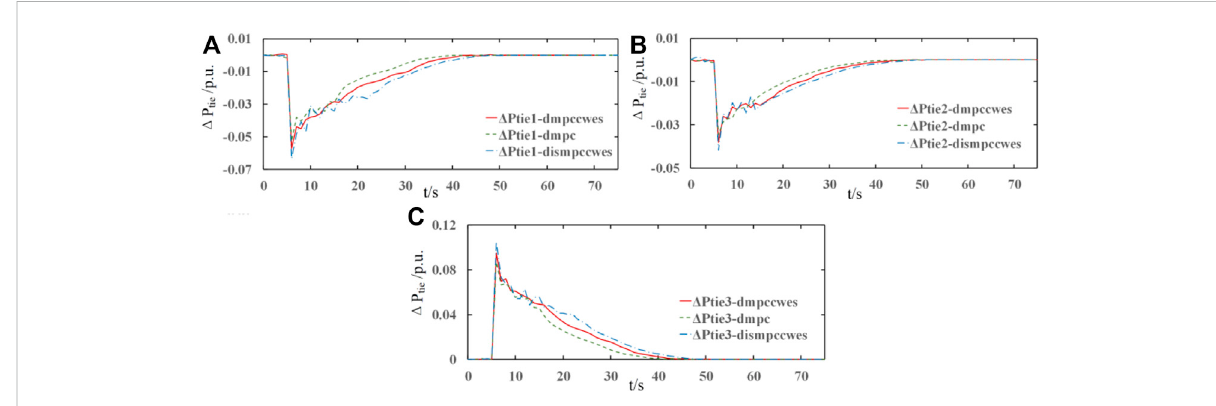
FIGURE 10 Power exchange of tie-lines between the adjacent areas. (A) active power exchange in the 1st area; (B) active power exchange in the 2nd area; (C) active power exchange in the 3rd